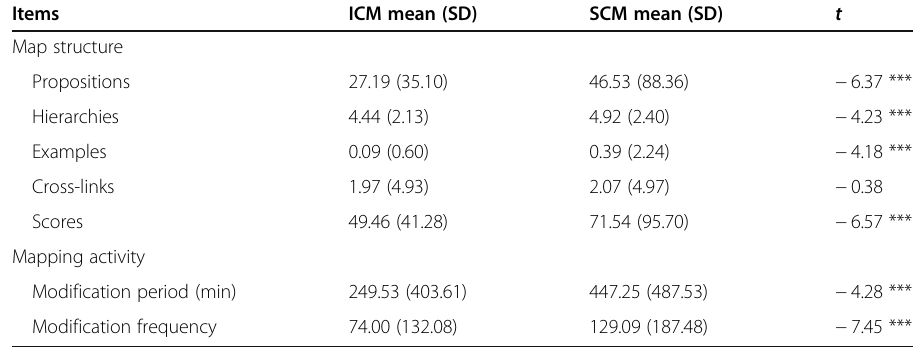
Table 4 Descriptive statistics and independent t test results for concept map structure and activity